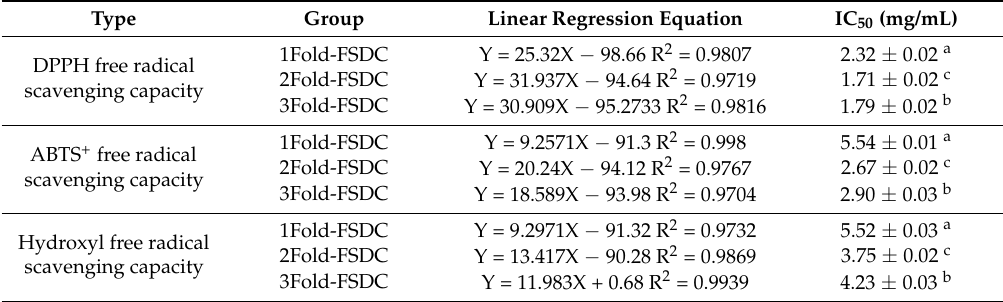
Table 8. DPPH (A), ABTS + (B), and hydroxyl (C) free radical scavenging capacity of Shuidouchi soaked in different amounts of water.